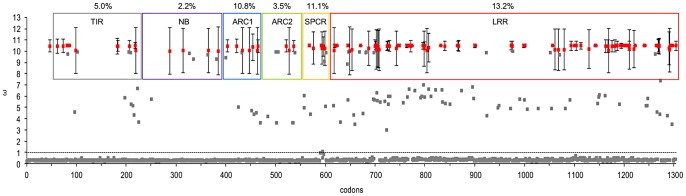
Scatter plot of ω values of codons found in the TIR (grey box), NB (purple box), ARC1 (blue box), ARC2 (green box), spacer (SPCR; orange box) and LRR (red box) regions of L locus R proteins.Codons with statistically significant (p>0.95) ω values are represented by red dots with error bars representing the standard error of the mean. The percentage of statistically significant positively selected codons is indicated above each region. The dashed line indicates a ω value of 1.